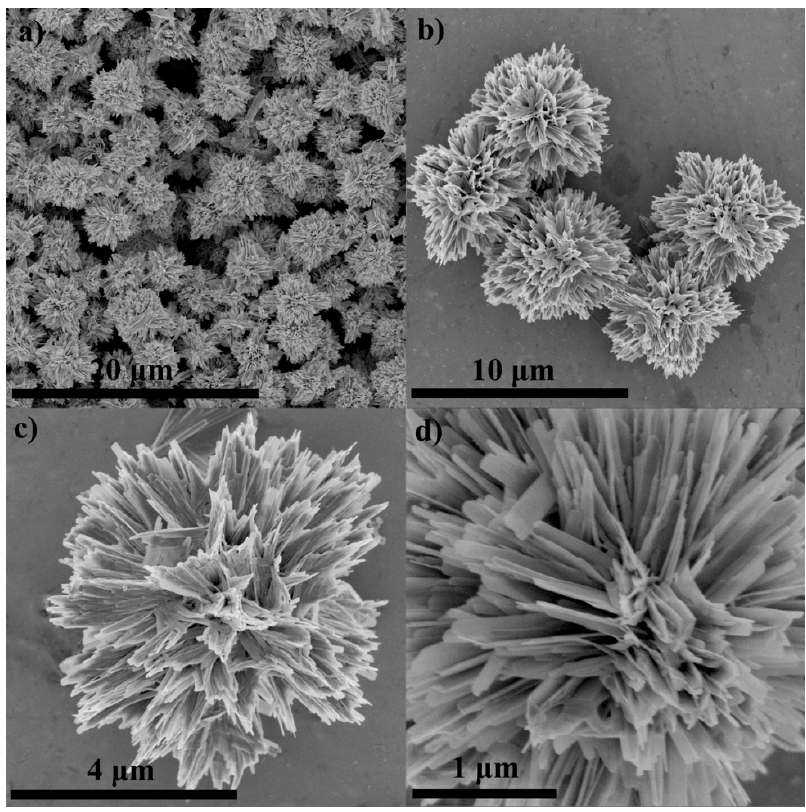
Figure 2. ( a – b ) low magnification; ( c – d ) high magnification FE-SEM images of the flower-like V 2 O 5 Figure 2. ( a , b ) low magnification; ( c , d ) high magnification FE-SEM images of the flower-like V 2 O 5 hierarchical nano structures [47]. hierarchical nano structures